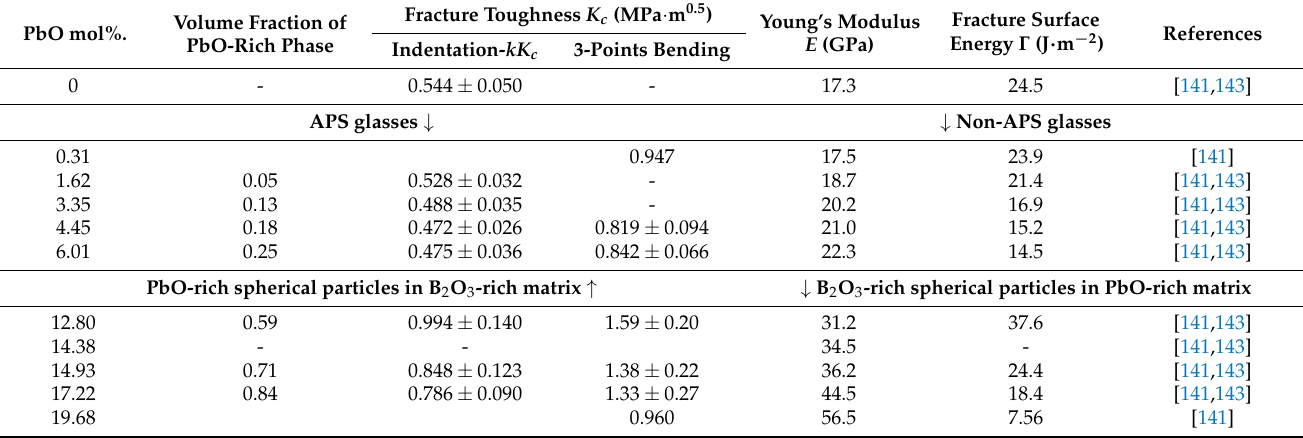
Table A1. Mechanical properties of PbO-B 2 O 3 glass system including APS zone [141,143] and non-APS zone [142]. Volume Fraction of PbO mol%. PbO-Rich